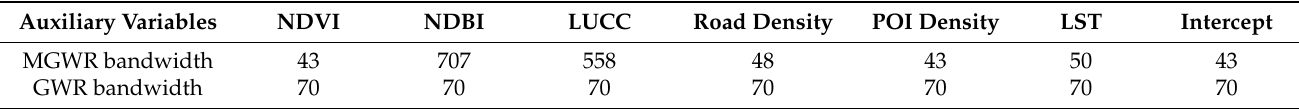
Table 4. Difference between GWR and MGWR bandwidth settings.